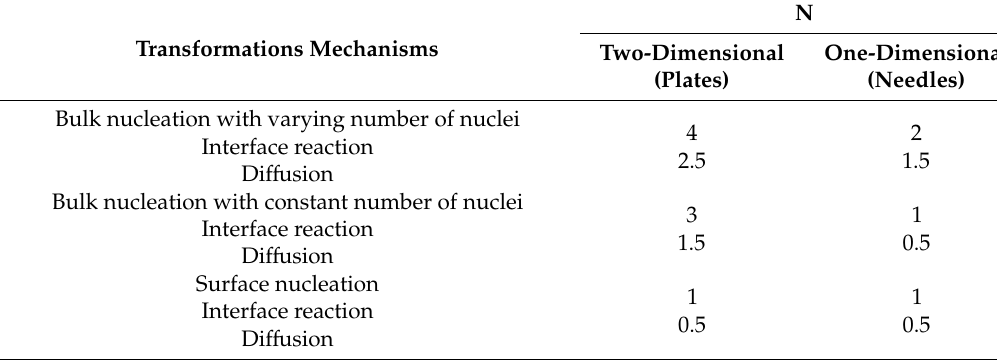
Figure 5. Kissinger plot values and the Avrami exponent, n for H, KCS, KRG, and KRG50H50. Table 2. Values of n for various transformations mechanisms [47].